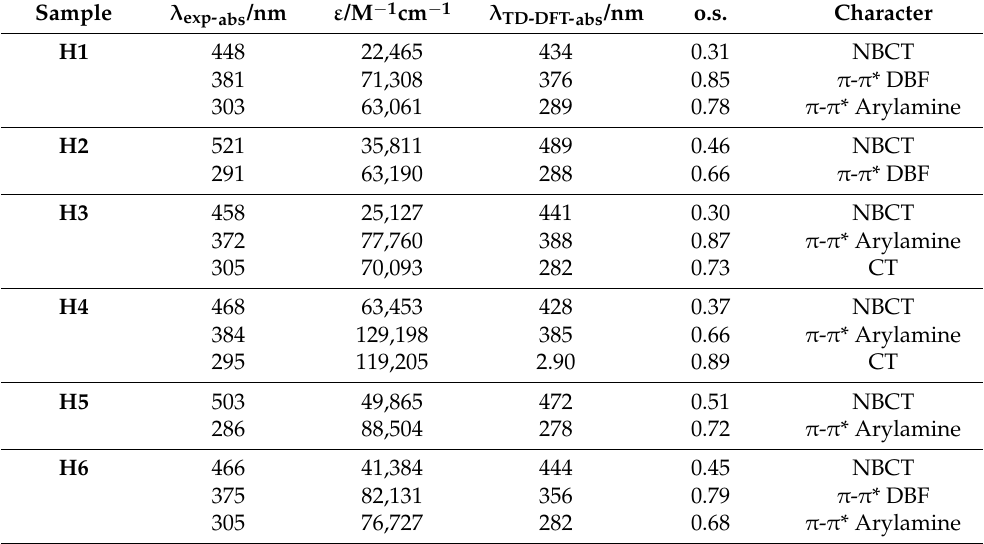
Table 1. Experimental absorption energies and molar absorption coefficients, as well as absorption energies, oscillator strengths (o.s) and transitions character from TD-DFT simulations. Sample